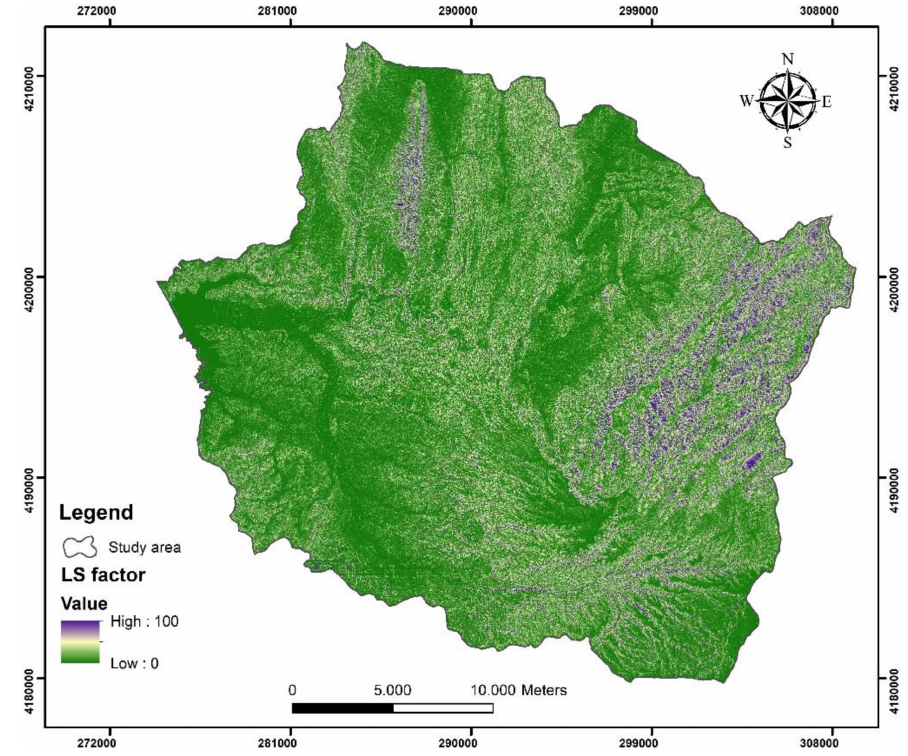
Figure 11. Slope length and steepness factor (LS) map of the pilot